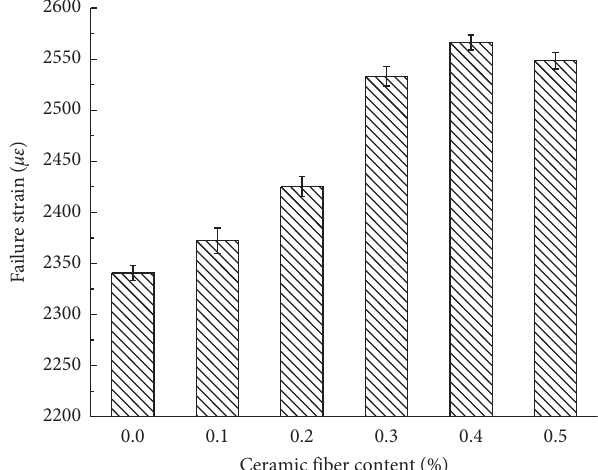
Figure 12: Results of low-temperature bending